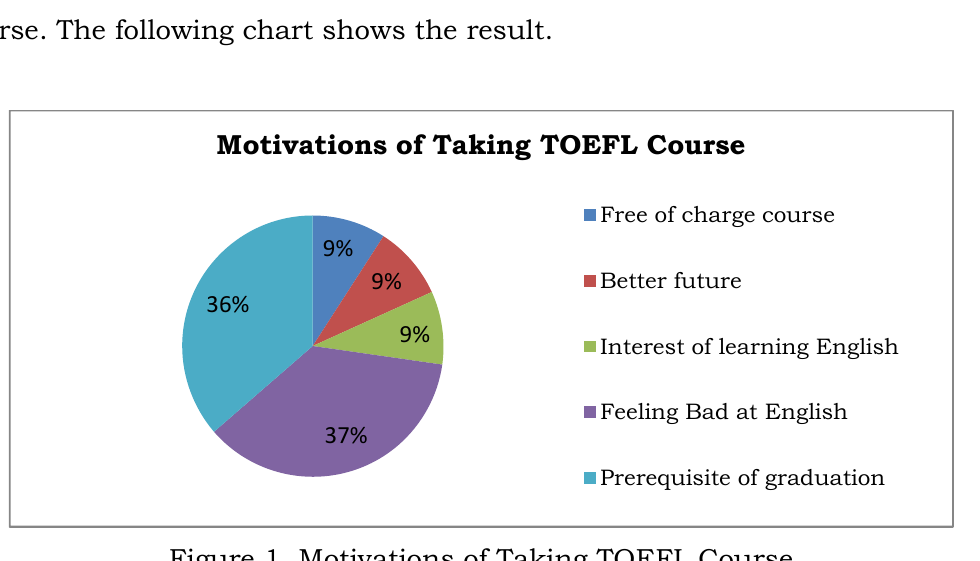
Figure 1. Motivations of Taking TOEFL